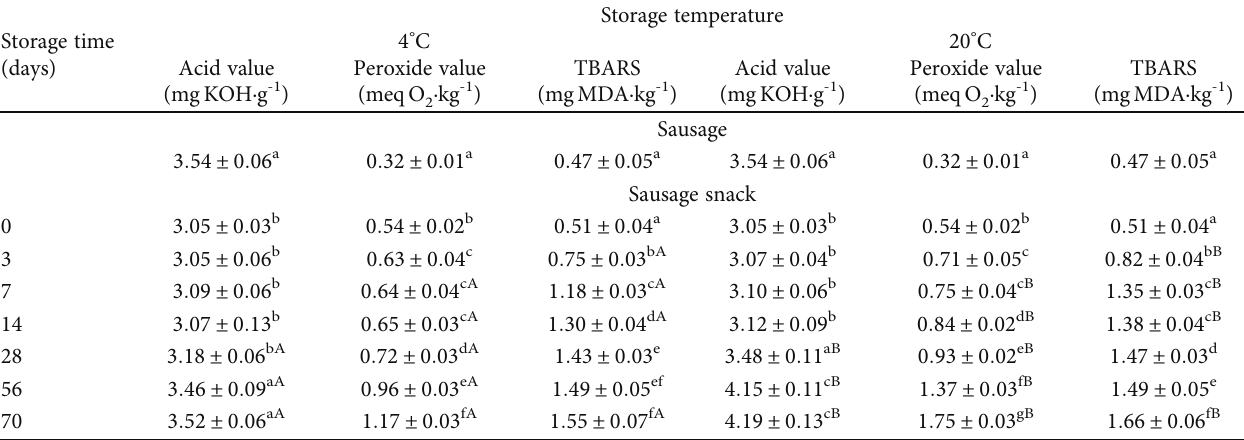
/80% N ) at 4 ° C and 20 ° C on fat quality indicators of sausage snack. 2 2